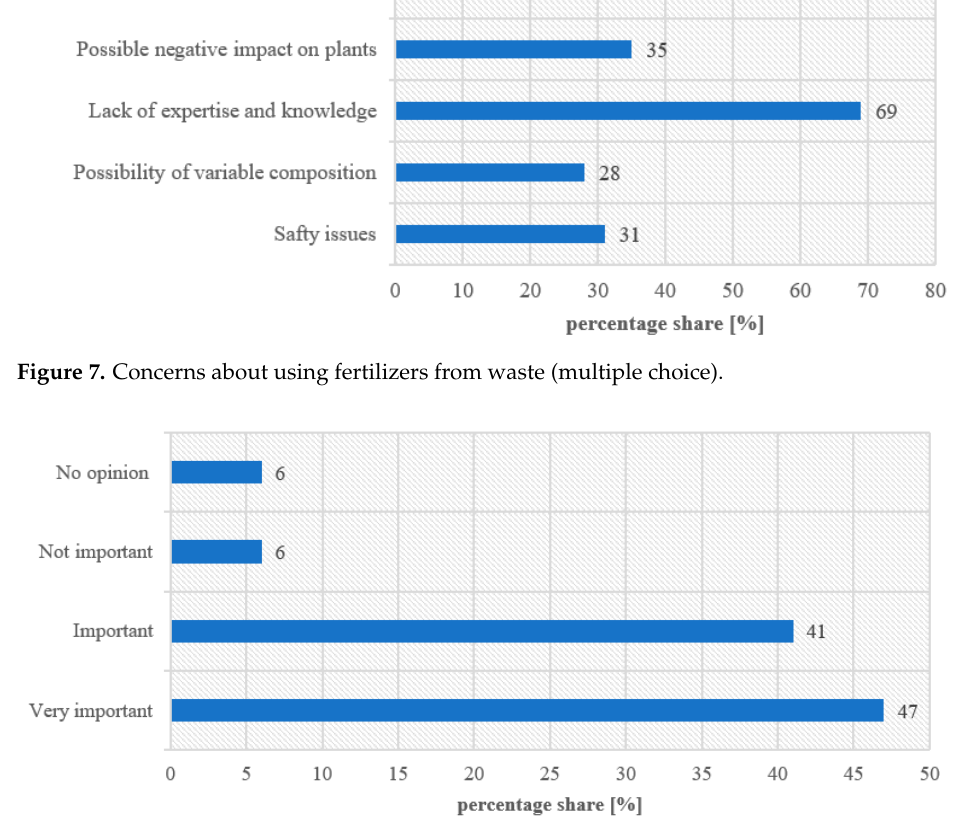
Figure 8. Importance of sustainable circular management of nutrient-rich waste.